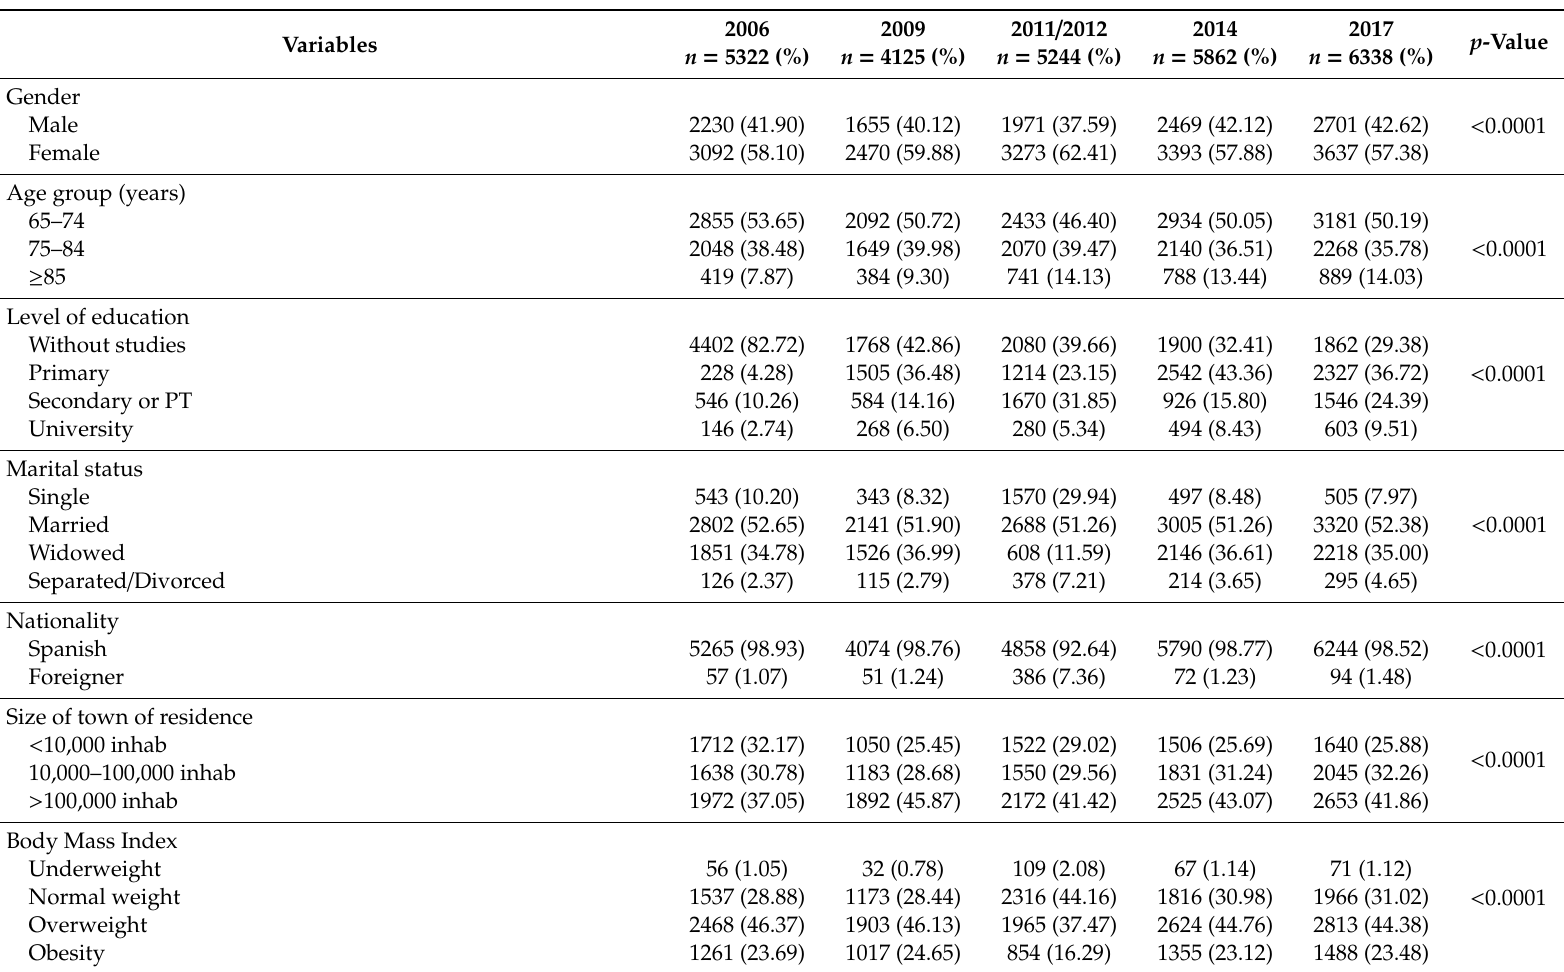
Table 1. Sociodemographic, lifestyle and health status variables of Spanish people aged ≥ 65 years (N = 26,891) (2006–2017).